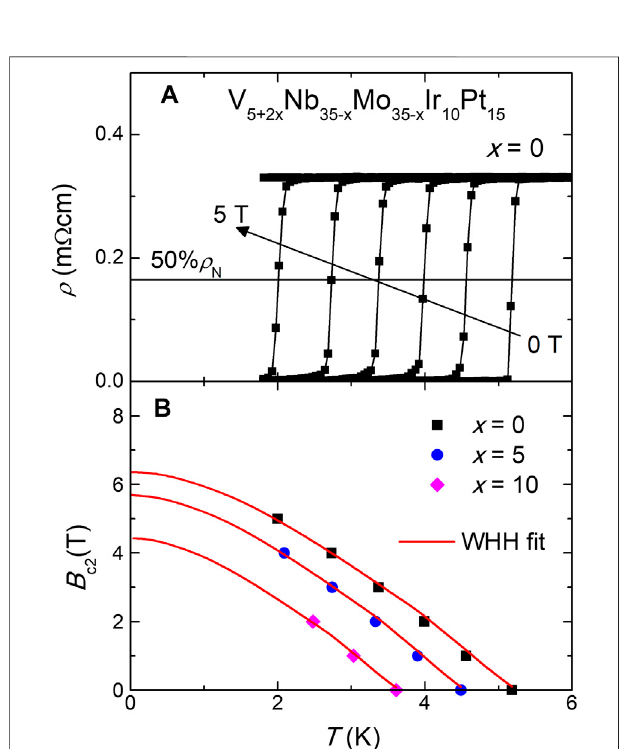
FIGURE 5 | (A) Temperature dependence of resistivity for the V corresponding to half of the resistivity drop and the increasing fi eld direction,respectively. (B) Temperaturedependenceoftheuppercritical fi elds for these HEAs. The solid lines are WHH fi ts to the